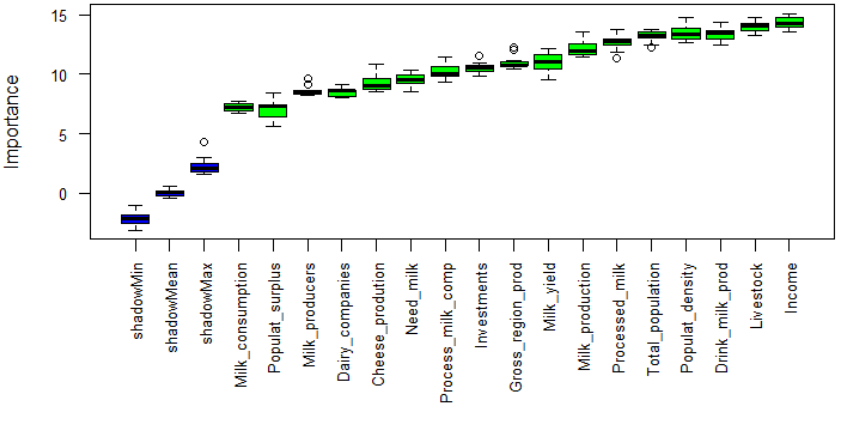
Figure 4. Feature selection with the Boruta algorithm using log-transformed response variable.